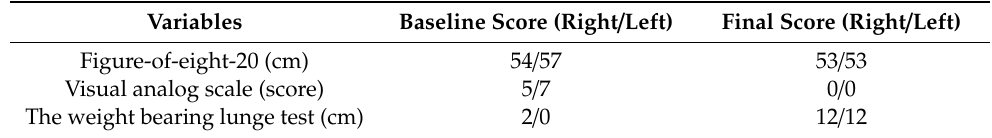
Table 1. Outcome of the physiological assessment.